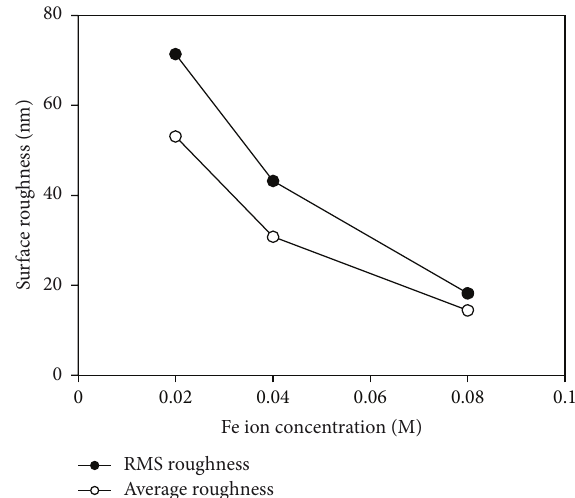
Figure5:Thevariationoftheaverageandthermssurfaceroughness in Fe–Cu films as a function of Fe ion concentration in the electrolyte. All lines are guide for the